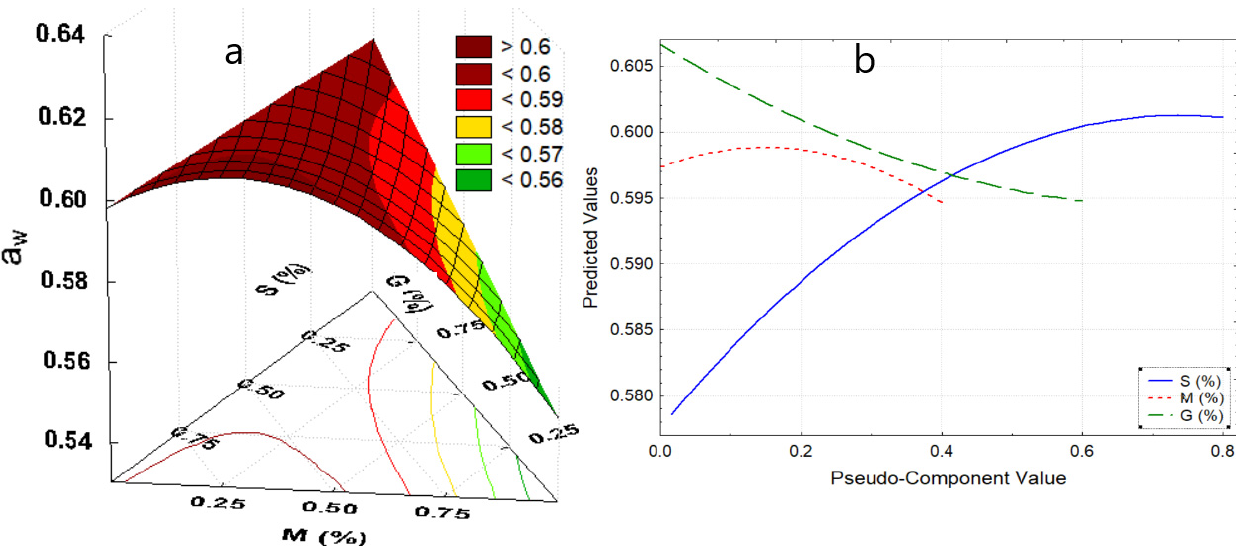
Figure 1. ( a ) Response surface for a w , ( b ) effects diagram for a w . Where: a w , water activity; S, starch; M, mucilage; G, glycerin.